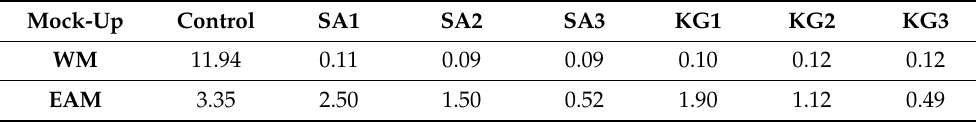
Table 4. Normalized counts of Cl (K α ) on sweat-WM and sweat-EAM, before (control) and after different cleaning applications with SA and KG.